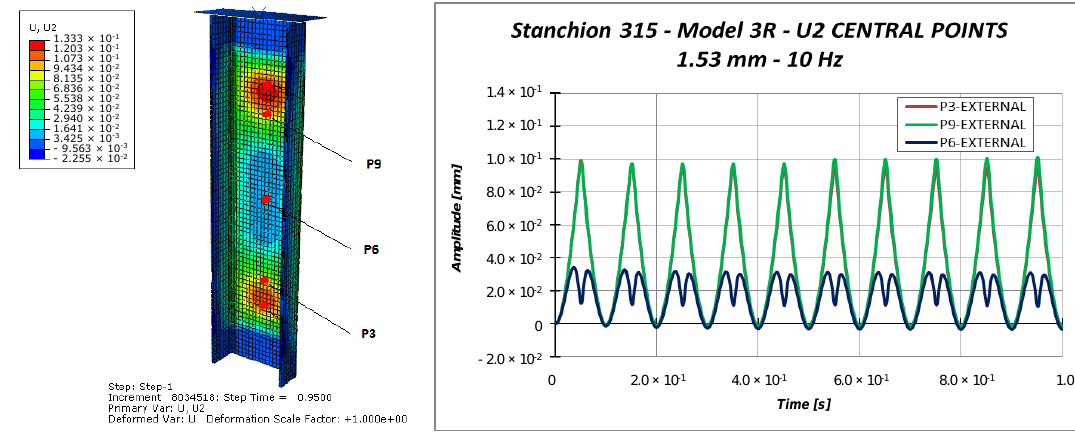
Figure 19. Out-of-plane displacement: 1.53 mm applied displacement.